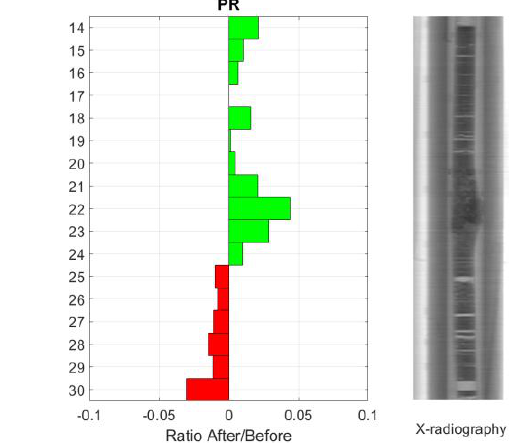
Fig. 12. Comparison of the final state of the upper part of the fuel rod obtained with the different